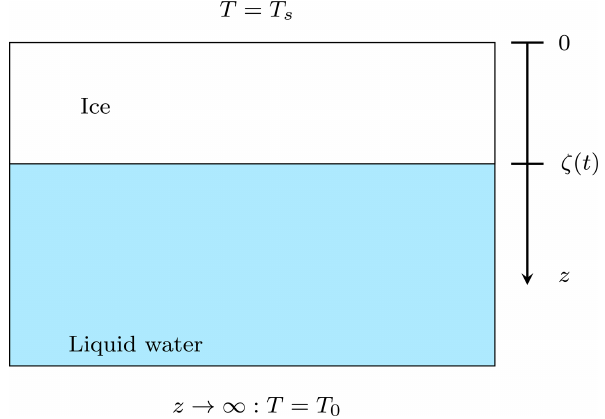
Figure 2. Scheme showing the setting of the Neumann solution for the freezing case. Initially all water is liquid, T 0 > T m . Because of the surface boundary condition, T s < T m , a freezing front, ζ , prop- agates downward.